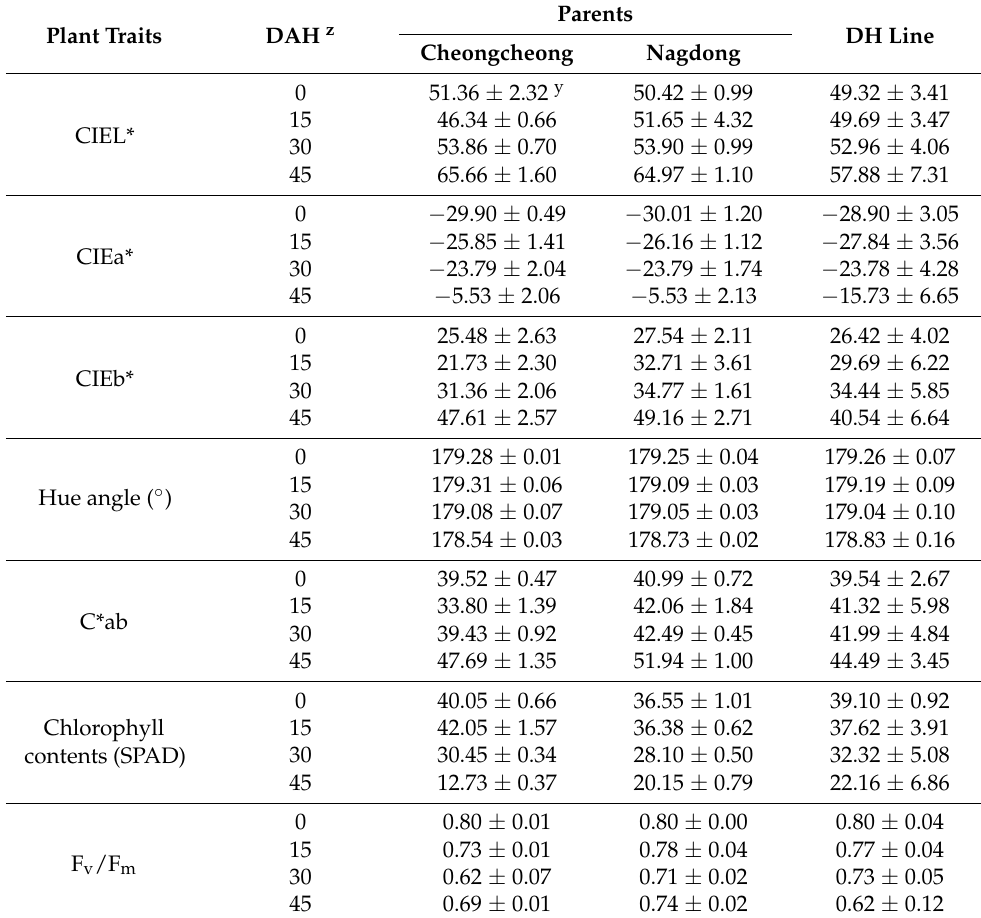
Table 1. Changes in leaf color, chlorophyll content, and F v /F m in Cheongcheong/Nagdong double haploid (CNDH) line.